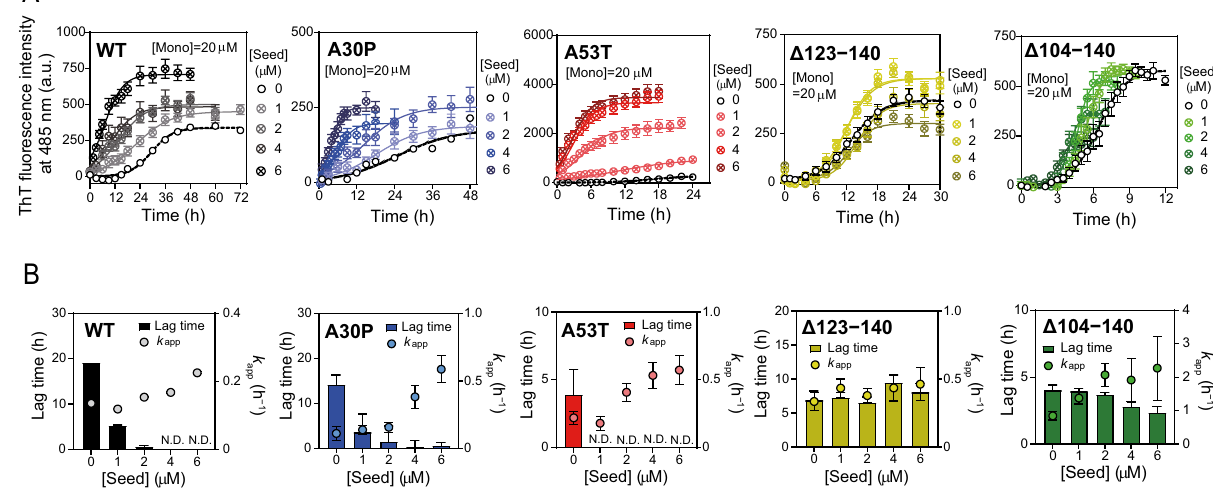
Figure 6. Seeded aggregation assay for α-syn variants with varying concentration of seed fibrils. ( A ) Traces of ThT fluorescence for fibril formation of α-syn with varying concentration of seed fibrils. Each experiment was repeated at least triplicated. Error bars represent S.E. The solid (seeded) and dashed (unseeded) lines are the fitted curves by the Finke–Watzky 2-step model. a.u. , arbitrary unit. ( B ) Comparison of lag time and apparent rate constant for fibril growth k app in fibril formation of α-syn variants with varying concentration of seed fibrils. Error bars represent S.E. N.D. , not